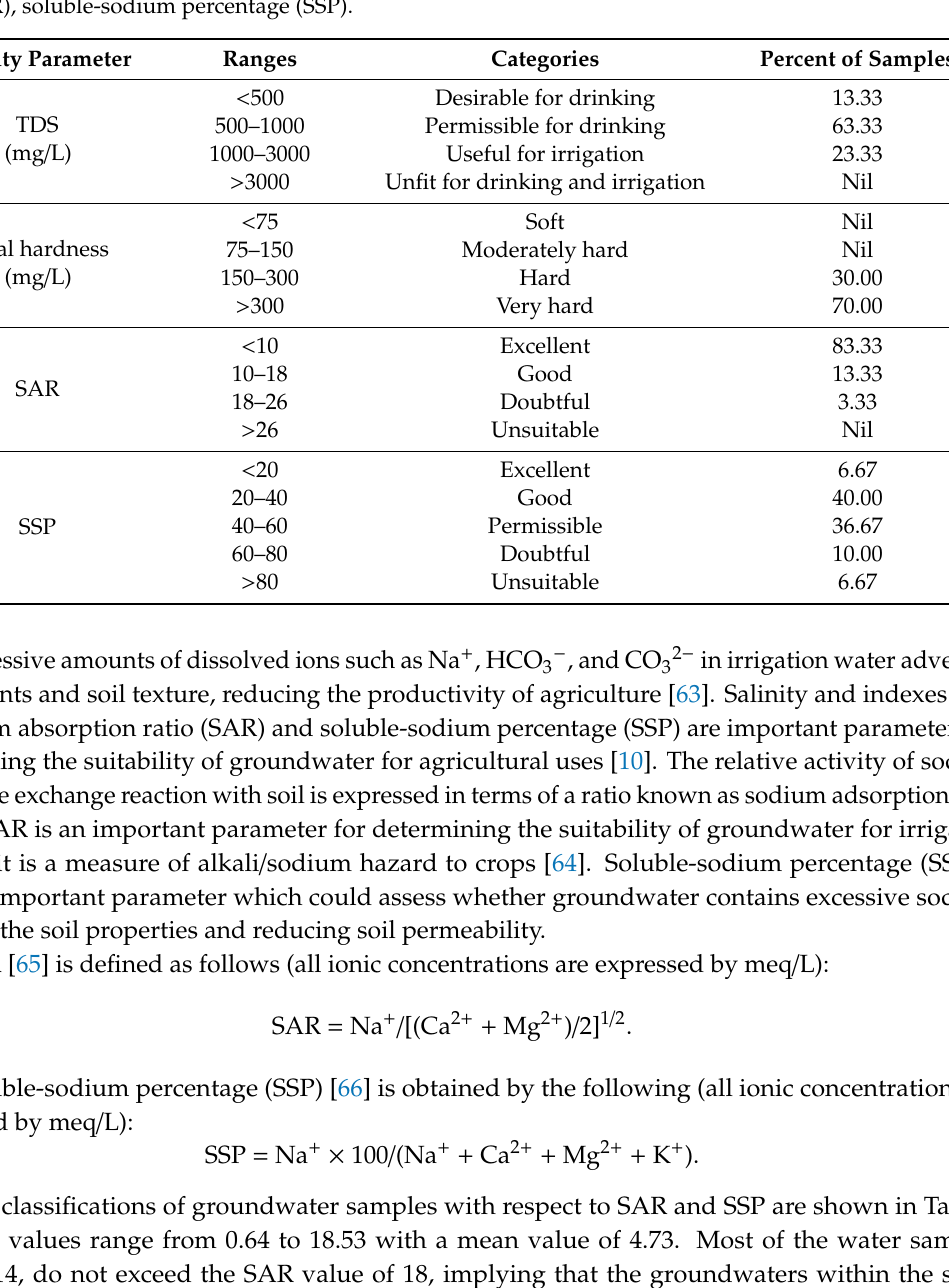
Table 4. Classification of groundwater based on TDS, total hardness (TH), sodium adsorption ration (SAR), soluble-sodium percentage